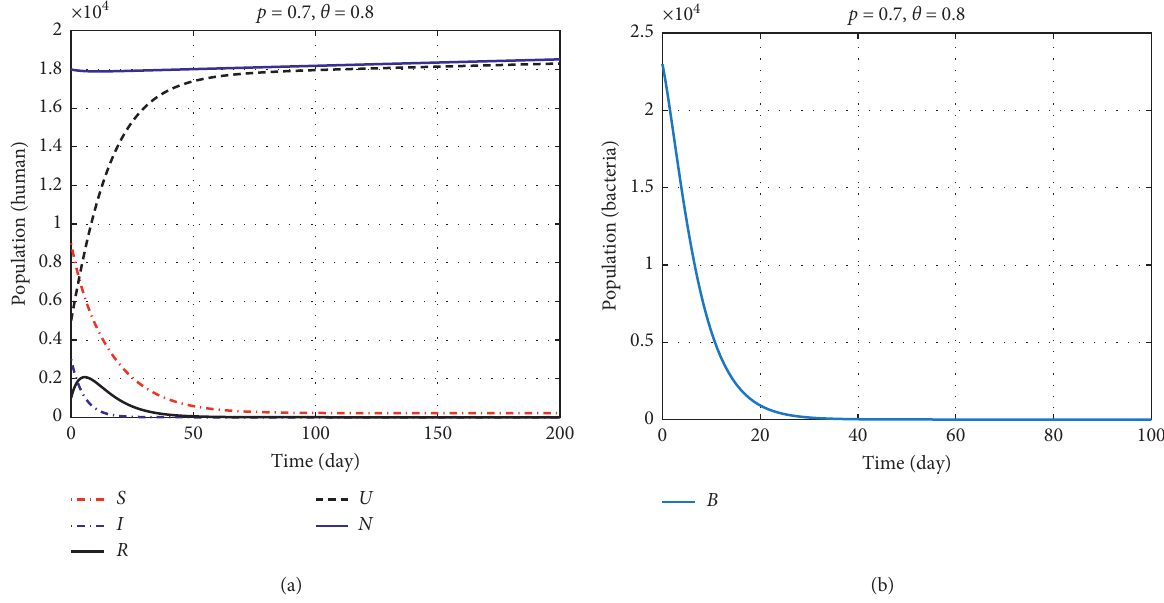
Figure 3: Time series solution of individual (a) and bacteria (b) cohorts when p � 0 . 7 and θ � 0 . 8. The diseases die out ( R